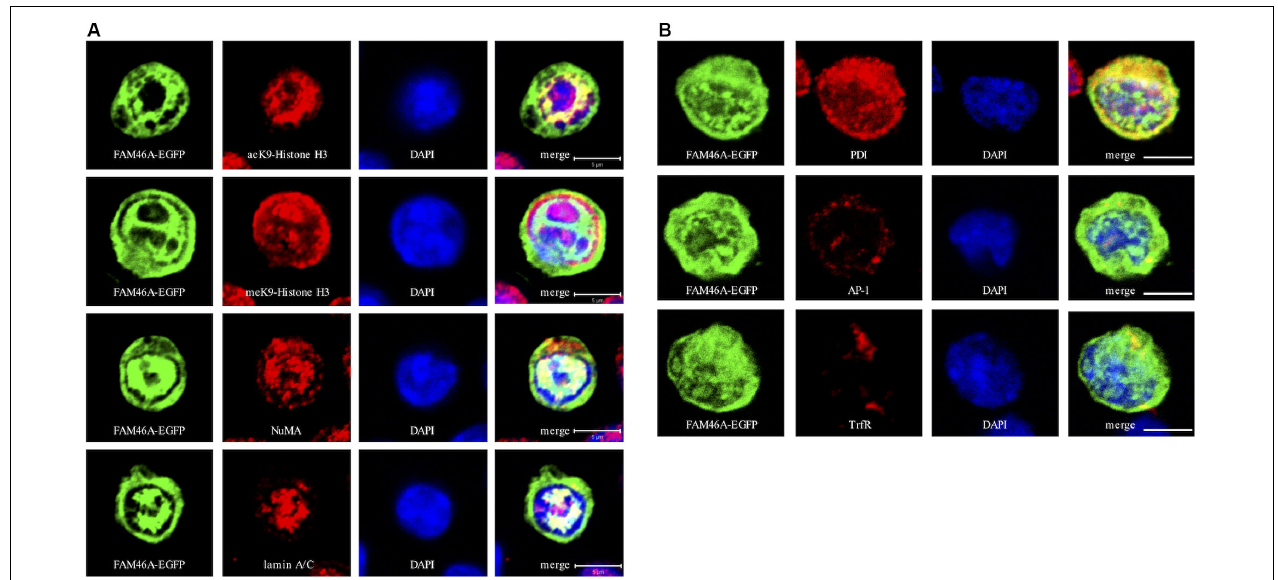
FIGURE 3 | Confocal analysis of the subcellular localization of FAM46A in transfected K562 cells. Cells were transfected with an expression construct encoding the FAM46A-EGFP protein, which was detected in the nuclear (A) and cytoplasmic (B) compartments. Within the nucleus (A) , FAM46A was predominantly confined in the chromatin domains more accessible to the transcription complexes (as indicated by the acK9-Histone H3 staining) and were mostly excluded from the regions with condensed chromatin structures (as indicated by the meK9-Histone H3 staining). In addition, significant co-localization of FAM46A with NuMA and lamin A/C was observed. DAPI staining defined the morphology of nuclei. Scale bar: 5 µ m. Within the cytoplasm (B) , the majority of FAM46A was found to co-localize with the endoplasmic reticulum marker, protein disulfide-isomerase (PDI). By contrast, co-localization of FAM46A with trans-Golgi network marker γ -adaptin (AP-1) and early endosome marker transferrin receptor (TrfR) is relatively low. DAPI staining defines the morphology of nuclei. Scale bar: 5 µ